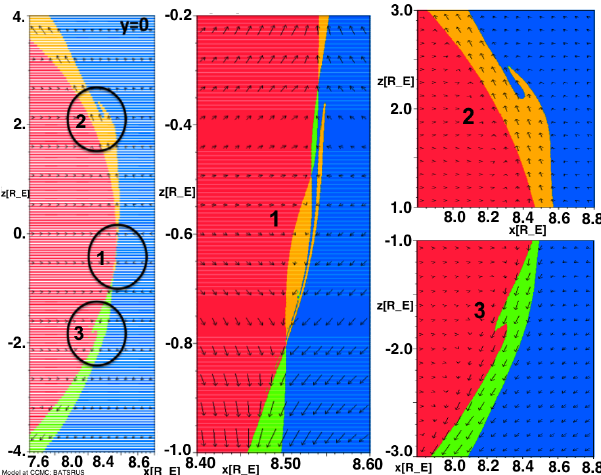
Fig. 17. Magnetic topology at t = 6min 30s for the noon-midnight plane ( z = 0, first plot) and for the equatorial plane ( y = 0, second plot). The X point is shifted from the subsolar point and located at z = − 0 . 7 and y = 2 . 2 R E . Colors are related to magnetic topol- ogy as red, closed; yellow, connected to north; green, connected to south; and blue, solar wind. Arrows indicate flow velocity.